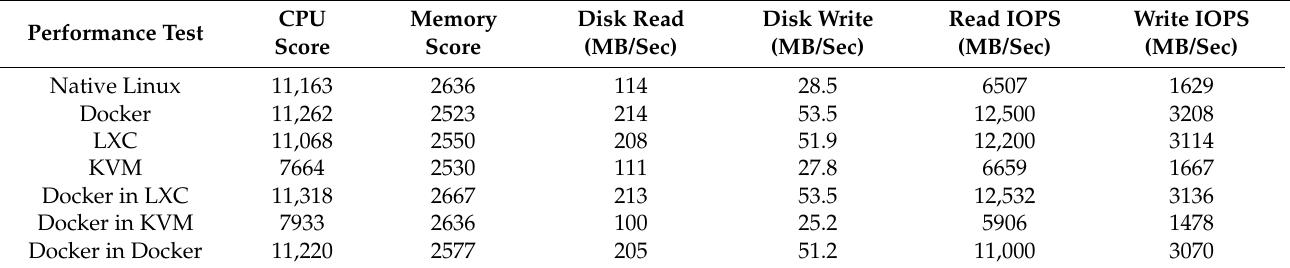
Table 3. Benchmark summary of the most popular virtualization/containerization